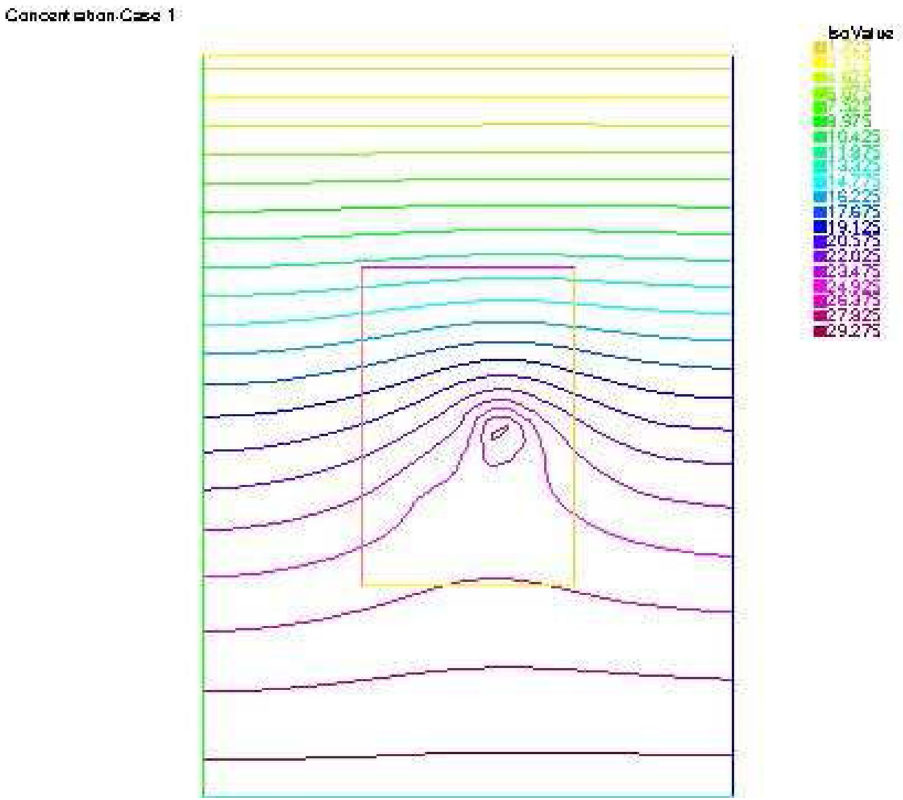
Figure 11. Pollutant concentrations—Case